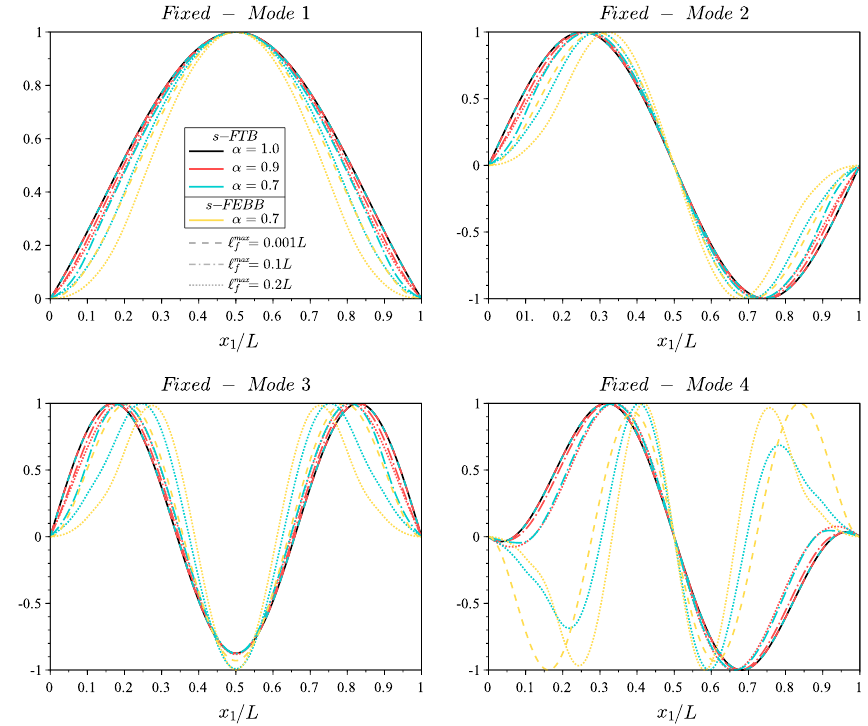
Figure 7. Shape of first four modes of fixed beam with length to height ratio L / b = 2 and Poisson’s = [ 0.001 L , 0.1 L , 0.2 L ] compared to the ratio ν = 0.2 for s-FTB model with α = [ 0.9, 0.7 ] and (cid:96) max f results of CTB model (s-FTB with α = 1.0) and the results of s-FEBB model with α =